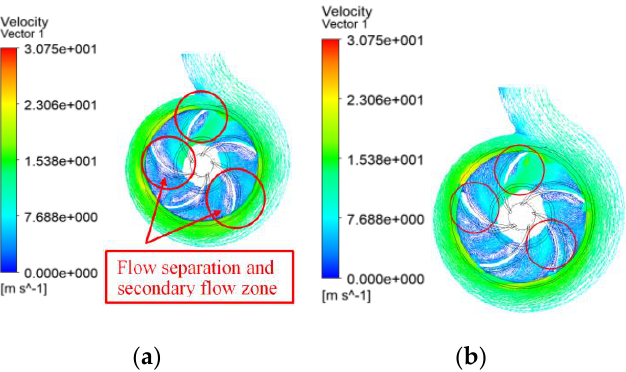
Figure 13. Velocity contours of flow region at 1250 rpm. ( a ) Original model; ( b ) rounded model.